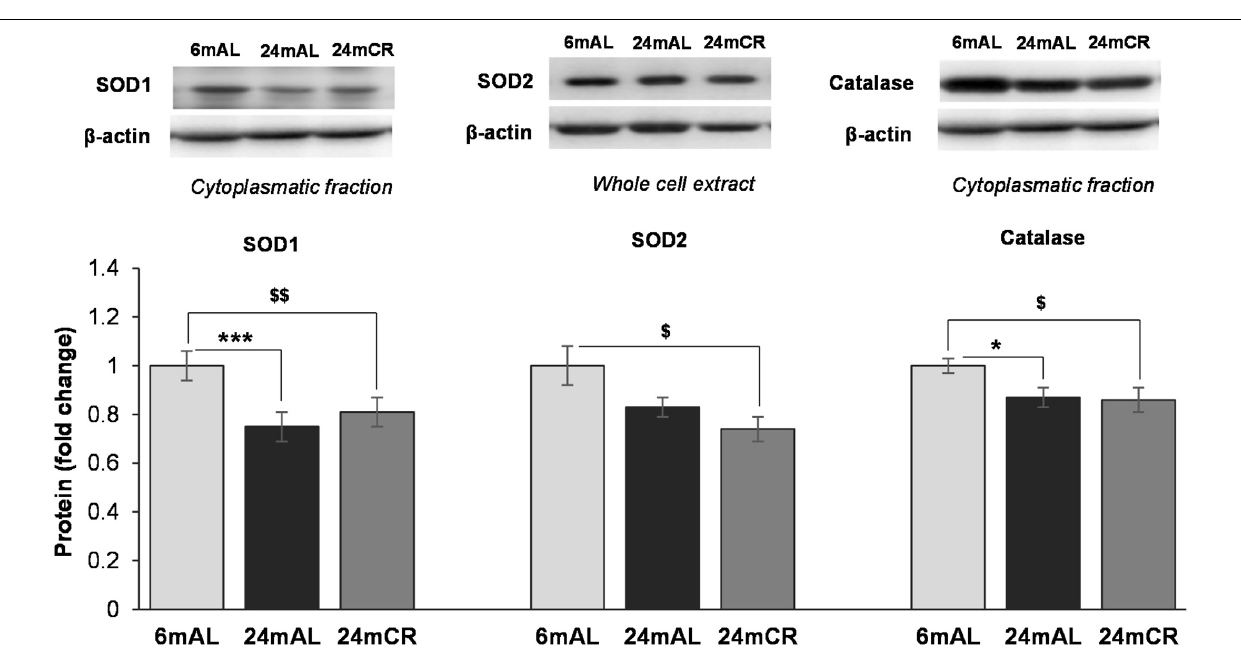
FIGURE 3 | Protein levels of antioxidant enzymes in the liver. Representative Western blots and relative quantification of SOD1 and Catalase in cytoplasmatic and SOD2 protein level in whole cell extract of the liver of adults (6 mAL), aged rats on AL diet (24 mAL), and old rats on CR (24 mCR). β -actin was used as the loading control for cytoplasmatic fraction and whole cell extract. All values are given as means ± SEM ( n = 8). Asterisk indicates a significant difference between aged rats on AL diet and adults (24 mAL vs. 6 mAL, * p < 0.05, *** p < 0.001) and symbol $ indicates a significant difference between old rats on CR and adults on AL diet (24 mCR vs. 6 mAL, $ p < 0.05, $$ p <